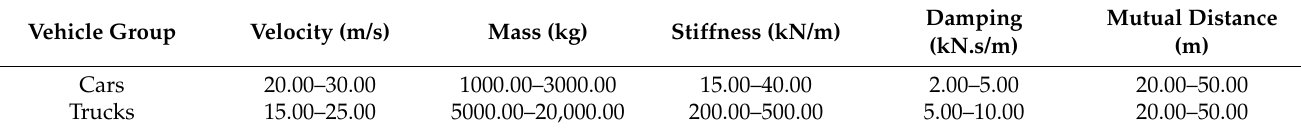
Table 4. Lower and upper bounds of the properties of cars and trucks moving on the bridge. Vehicle Group Velocity (m/s) Mass (kg) Stiffness (kN/m)